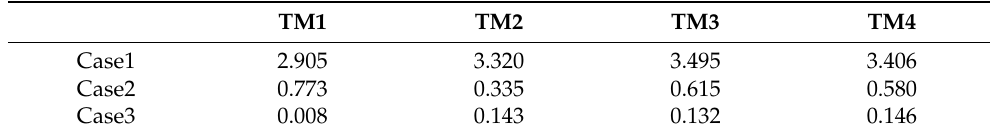
Table 5. NMAPE of estimated cable axial force for each TM and